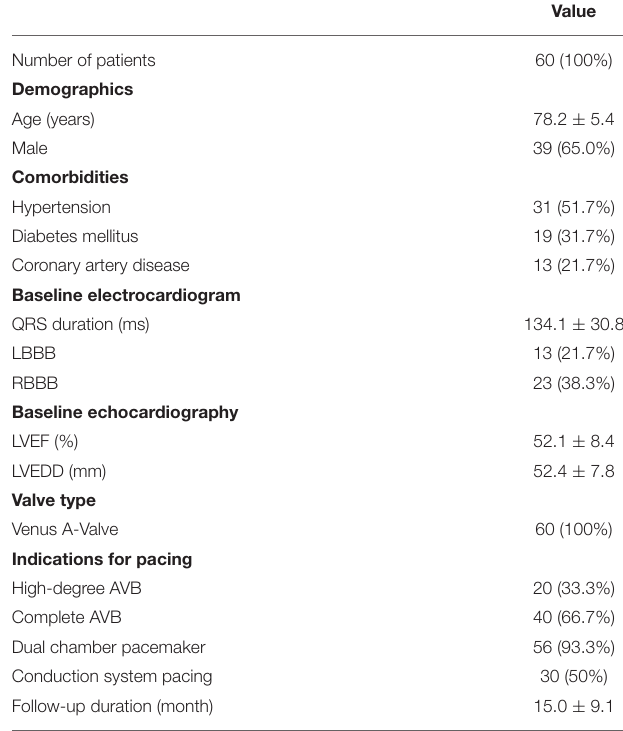
TABLE 1 | Baseline